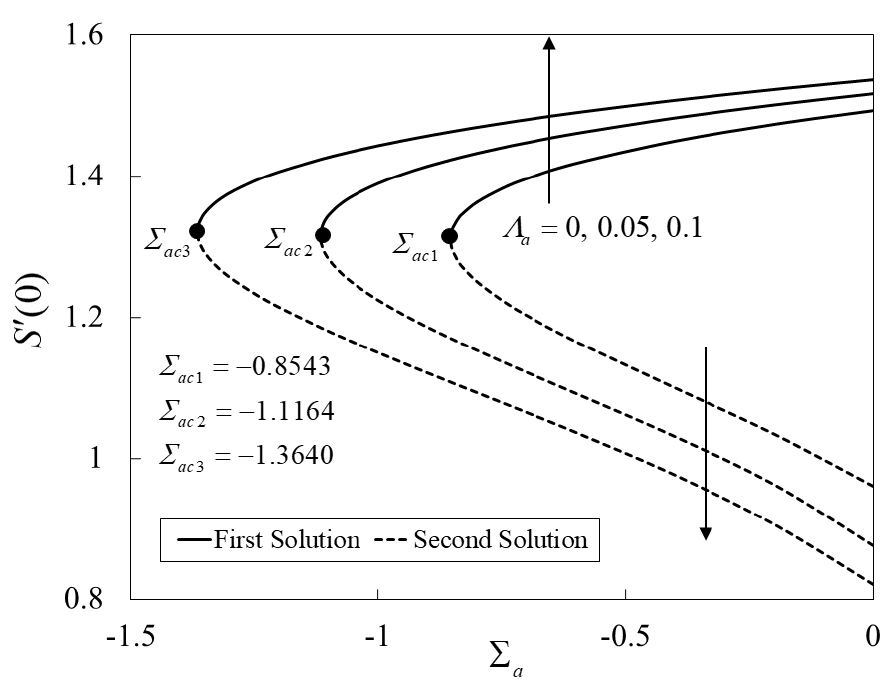
Figure 4. Variation in the local Sherwood number   ' 0 S with  a for different values of  a